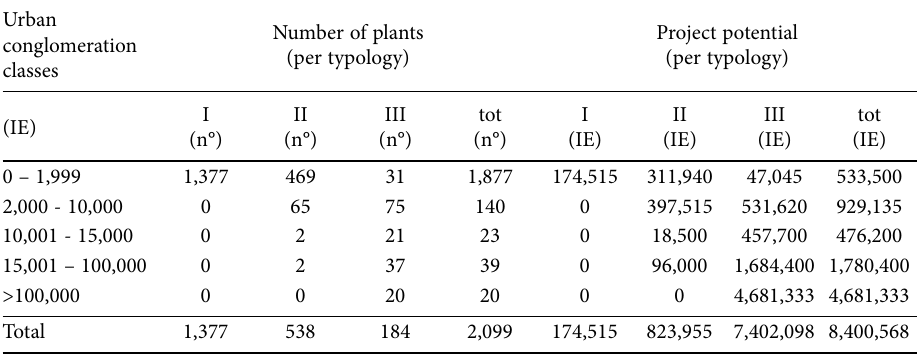
Table 3. WWTPs in the Emilia-Romagna region per typology and conglomeration classes in 2012.